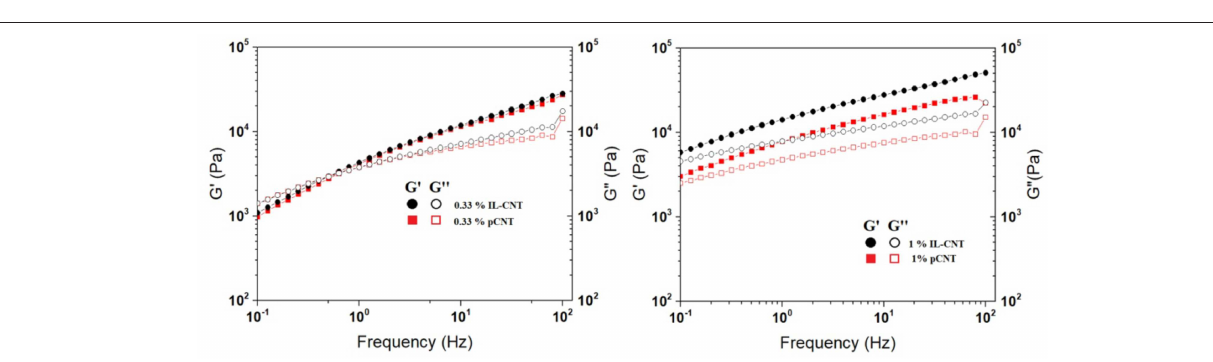
FIGURE 4 | G’ and G” vs. frequency of PS/PBAT loaded with 0.33 and 1.0 % of CNT.